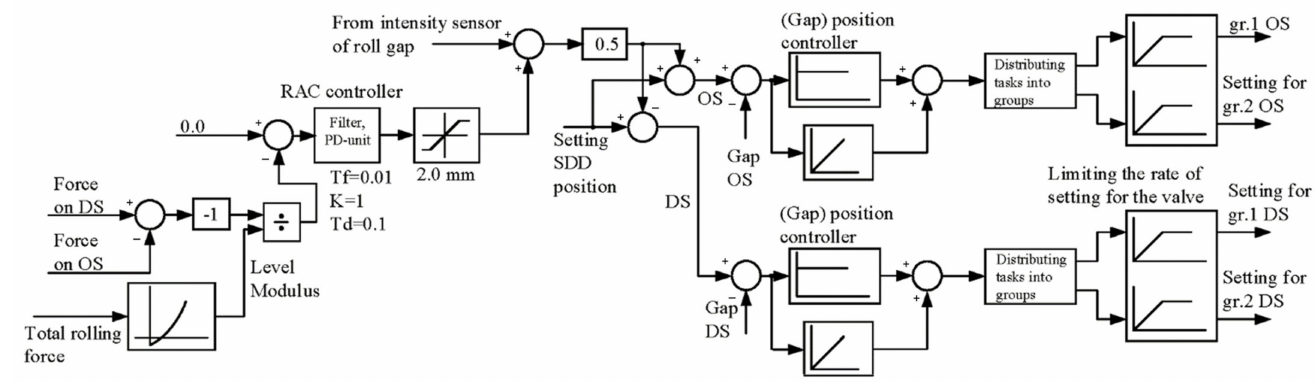
Figure 5. Diagram of connection of the RAC controller to the control system for hydraulic SD